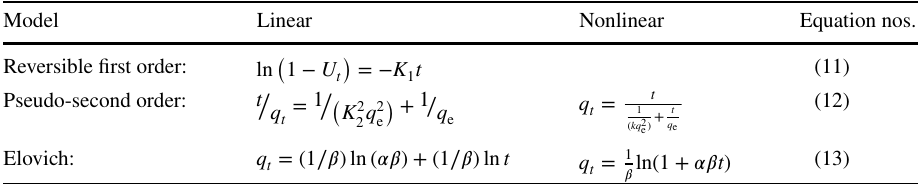
Table 3 Linear and nonlinear Model Linear kinetic models